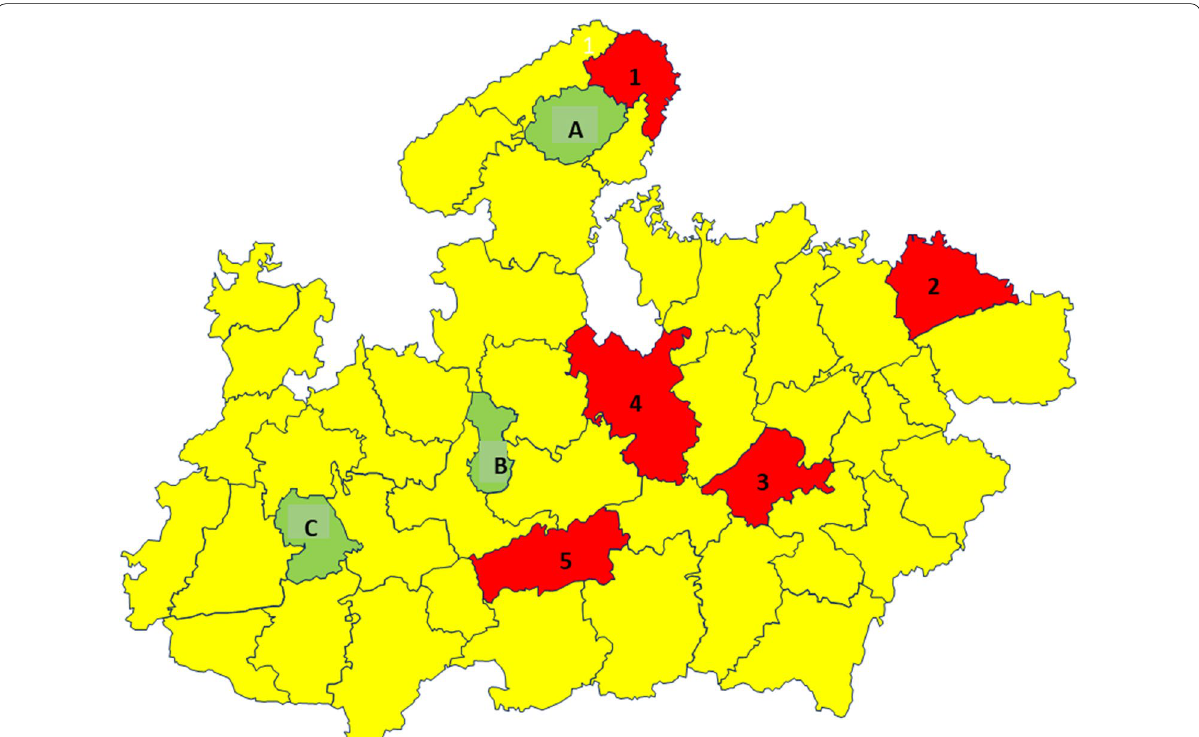
Fig. 27 Predicted vulnerable districts (1-Bhind, 2-Rewa, 3-Jabalpur, 4-Sagar, 5-Hoshangabad) and less vulnerable districts (A-Gwalior, B-Bhopal, C-Indore) for Horticultural crops. The red coloured districts are more vulnerable to climate change, therefore crop production will be at risk, whereas the green coloured districts are at the least